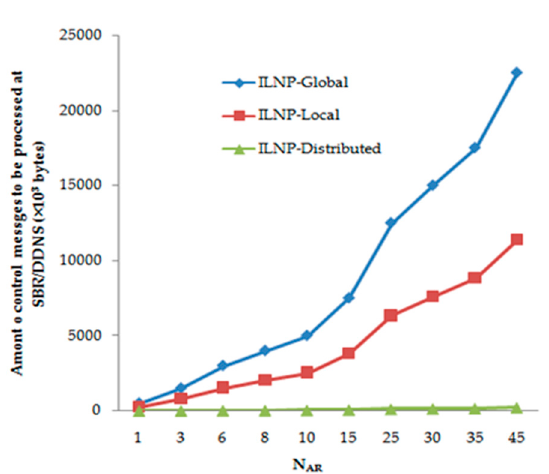
Figure 10. Impact of N Host/AR on CTO.